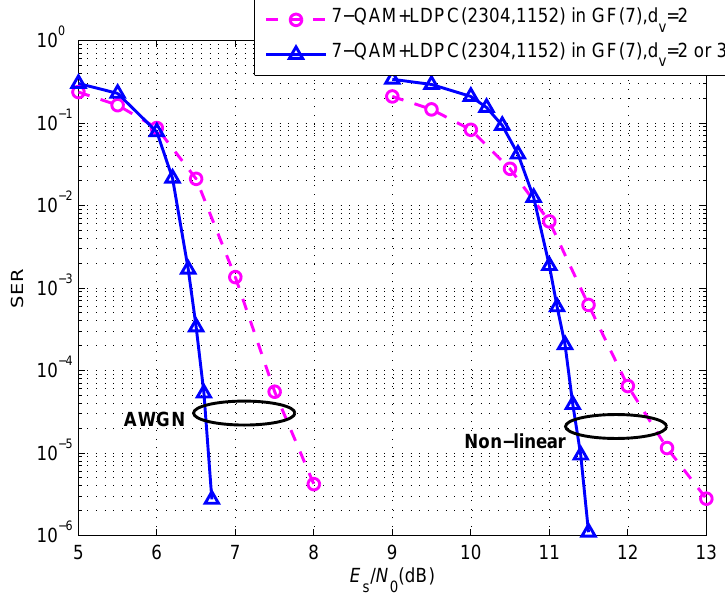
Figure 9. SER of 7-QAM combined with different NB-LDPC codes over different channels.